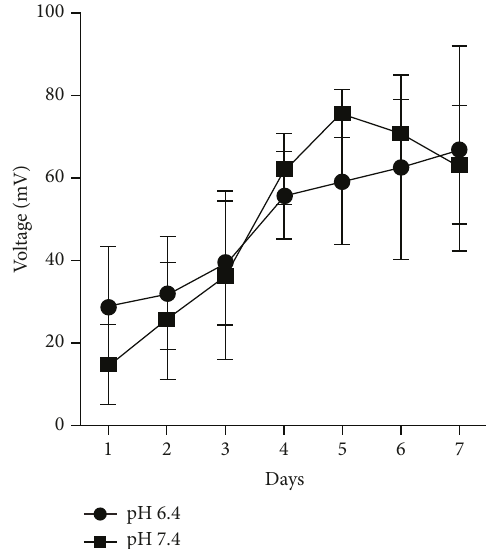
Figure 2: Voltage (mV) achieved over 7 days from two-chambered MFC units at different pH (6.4 and 7.4), with H. salinarum as the anodic organism at a ratio of 1 :24, maintained at 37 ° C, with constant shaking at 50 rpm. Each MFC unit consisted of 5 cm 2 electrodes. The data points represent the daily average voltage (mV ± SEM) of readings recorded every 30 minutes for 7 days from 3-4 separate experiments. There was no significant difference ( p � 0 . 9663) in voltage due to pH based on an unpaired T -test with Welch